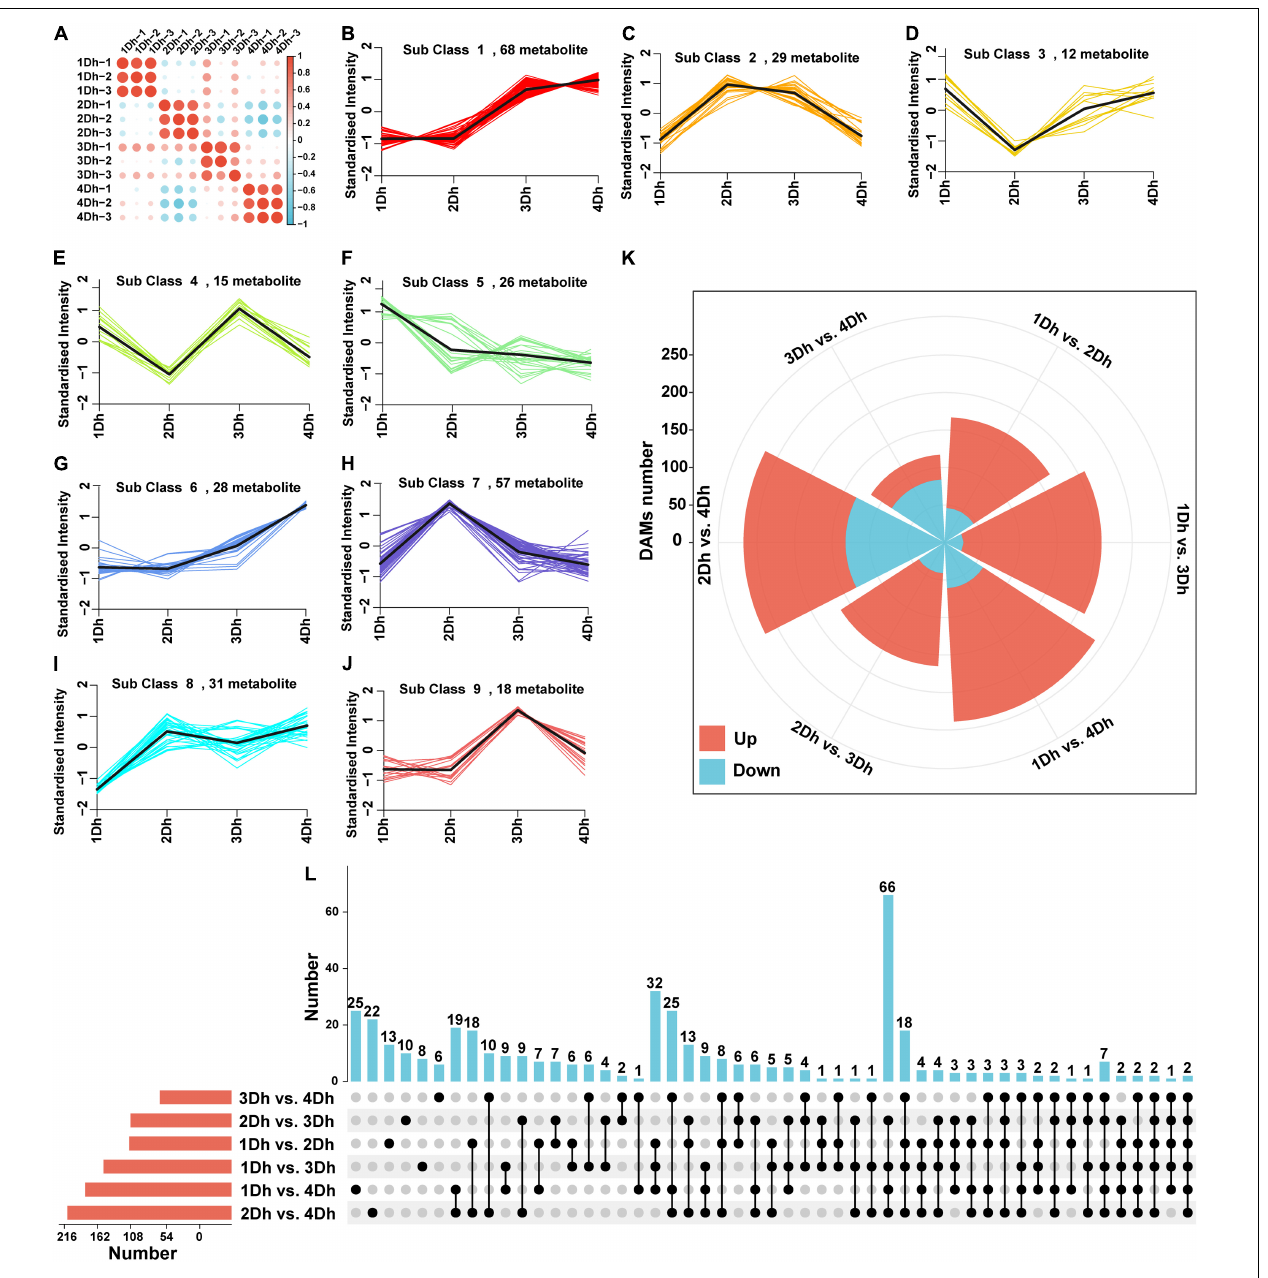
FIGURE 4 | Metabolomic analyses of D.huoshanense of different growth years. (A) Correlation heatmap of all the samples; (B–J) The K means analysis of DAMs. (K) Rose diagram of the up- and down-regulated distribution of DAMs. (L) UpSet diagram of DAMs in different comparison